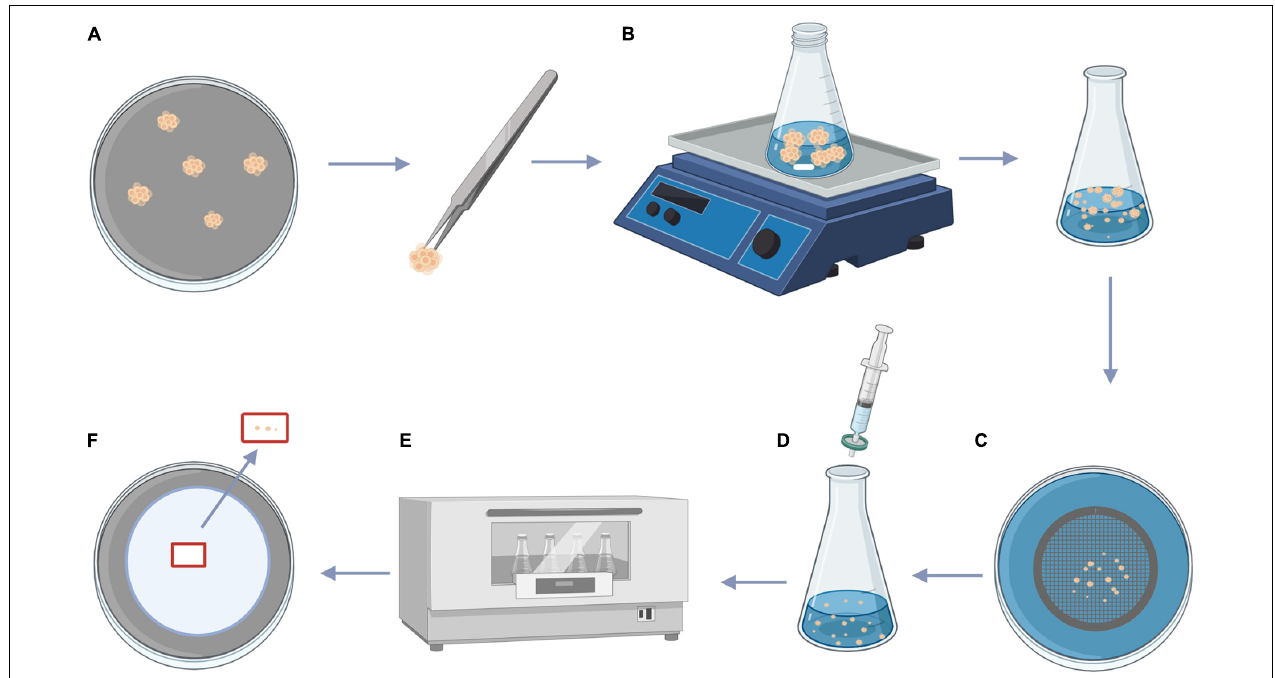
FIGURE 1 | Procedure for size fractionation of ECAs and colchicine treatment. (A) PEMs of Magnolia officinalis proliferated on M2 medium. (B) PEMs of M. officinalis were transferred to 50 mL Erlenmeyer flask containing 20 mL of M3 liquid medium with the magnetic agitator, the Erlenmeyer flask was placed in a magnetic mixer at 0 ◦ C and 1,000 rpm for dispersion. (C) After 10 min, the dispersed PEMs were passed through 100 and 200 µ m sieves, producing a homogeneous suspension composed of ECAs with a diameter of 100–200 µ m. (D) Filter sterilized colchicine solution was added to the ECA suspensions. (E) ECAs were treated with colchicine at different concentrations on an orbital shaker (100 rpm) at 25 ◦ C for 24, 48, and 72 h. (F) Following colchicine treatment, ECAs were washed and plated on M4 medium for somatic embryo initiation. This figure was created using BioRender